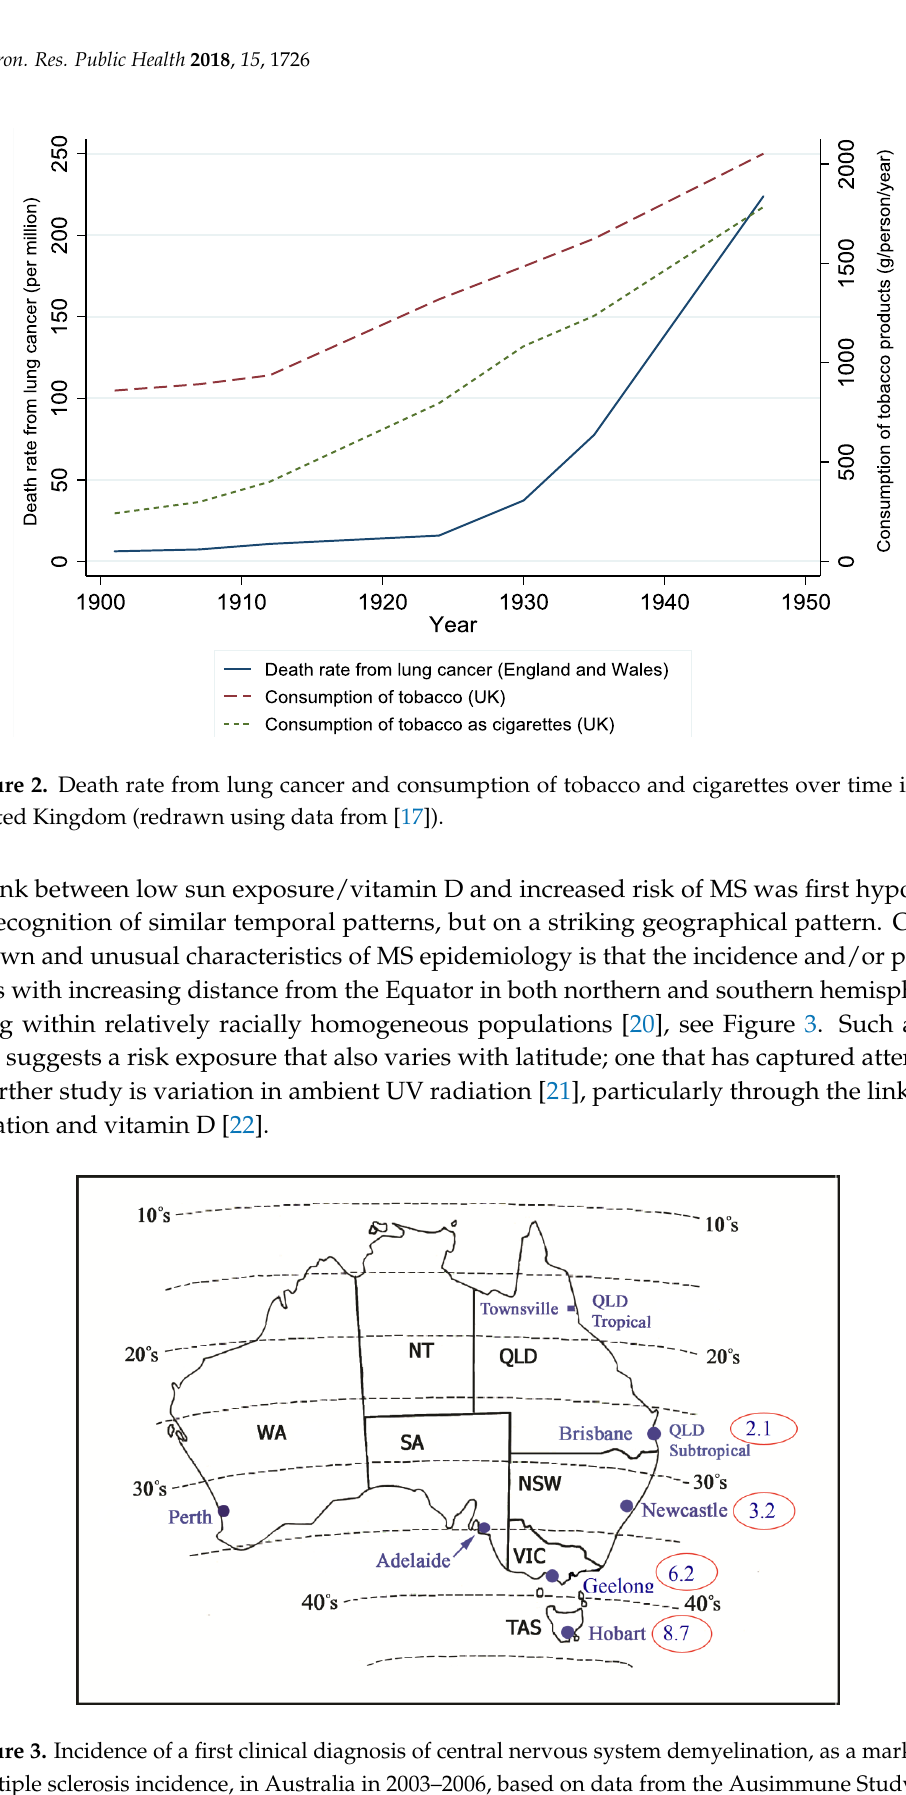
Figure 3. Incidence of a first clinical diagnosis of central nervous system demyelination, as a marker of multiple sclerosis incidence, in Australia in 2003–2006, based on data from the Ausimmune Study [20] (dotted lines represent latitude, annual incidence (per 100,000 population) is circled).